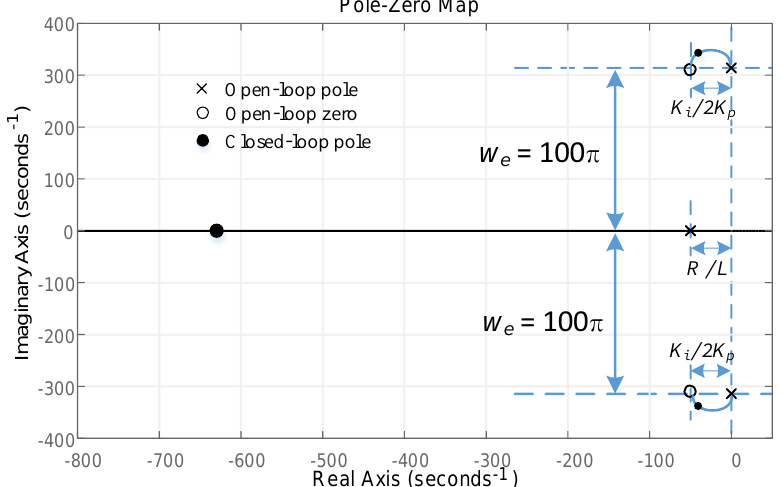
Figure 10. Root locus diagram of the current loop in the shunt converter.